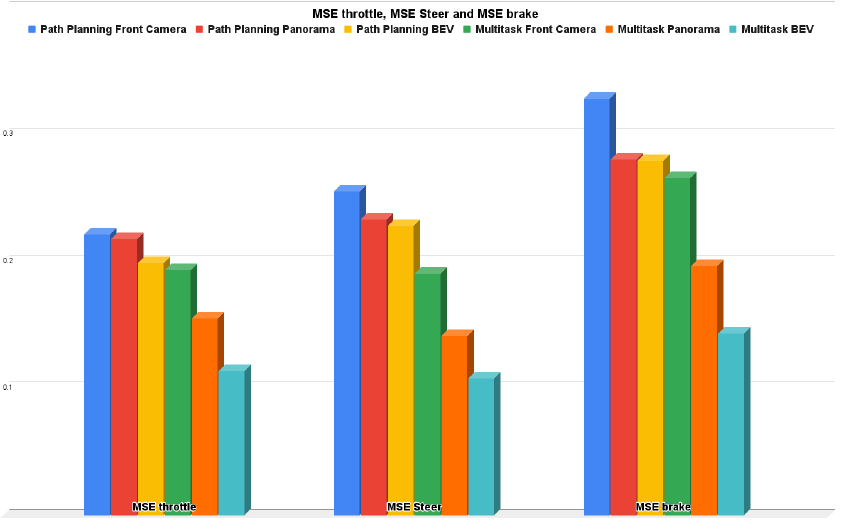
Figure 15. MSE throttle, steer, and brake for path planning for AEB only vs.